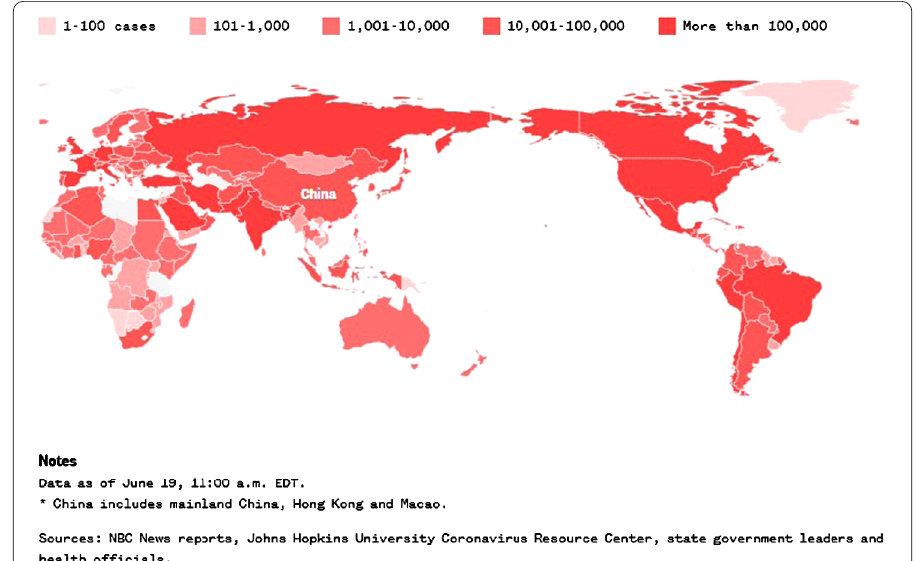
Figure 2 Concentration of COVID-19 cases worldwide as on June 19,